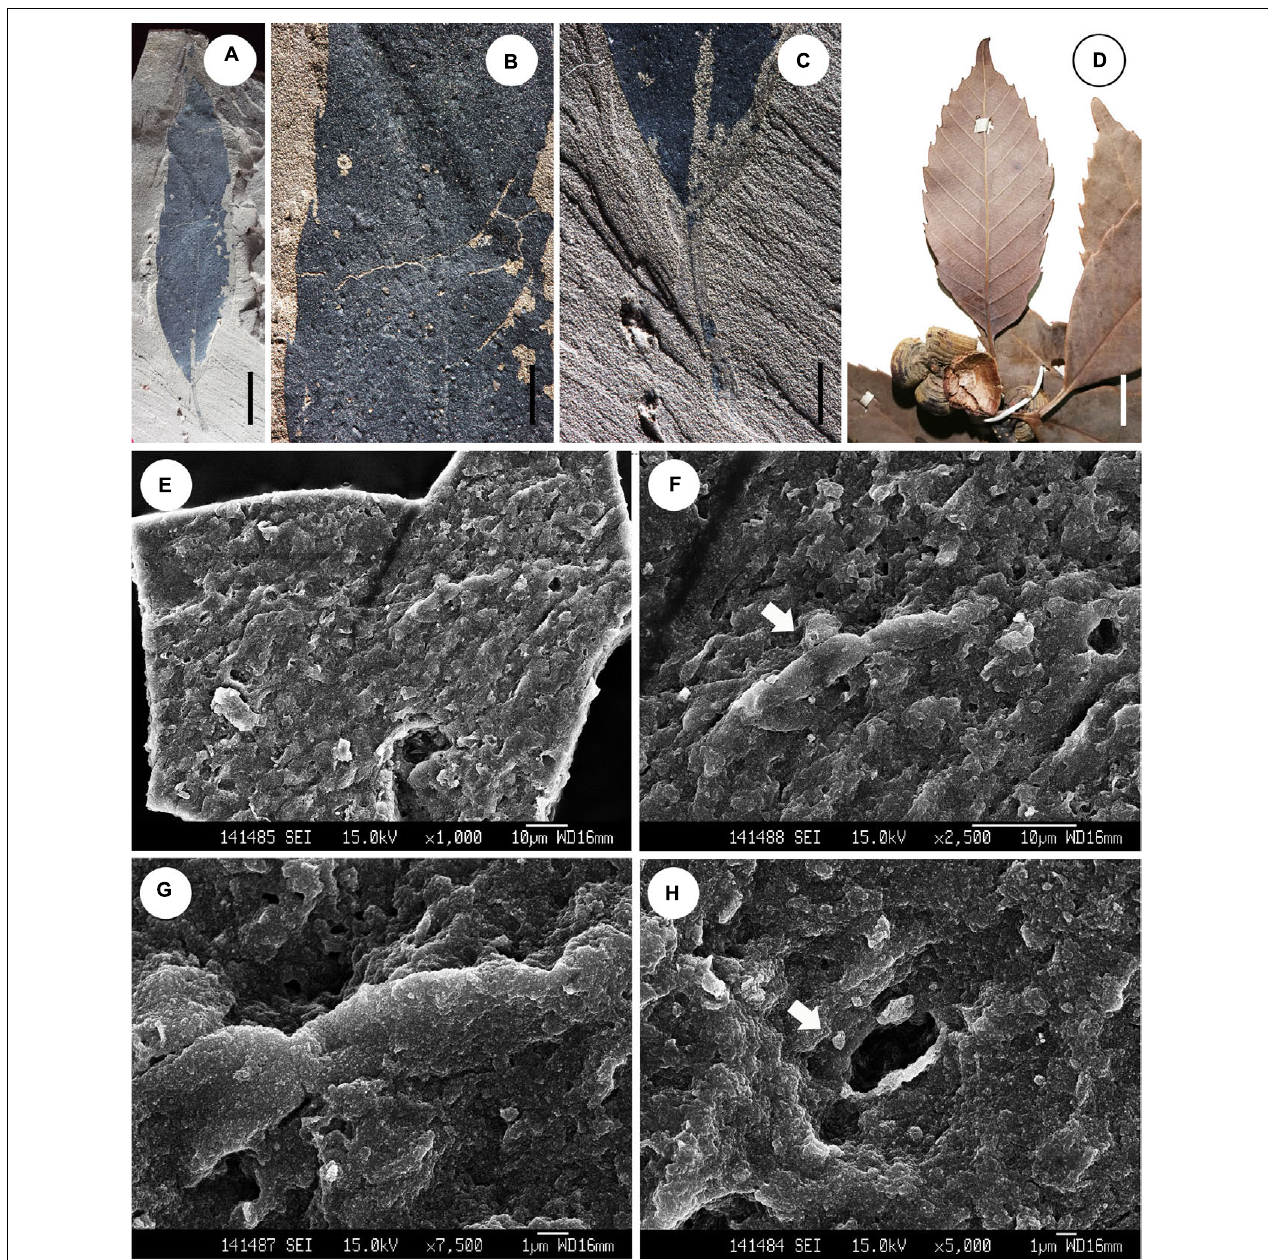
FIGURE 13 | Morphology of Quercus changchangensis sp. nov. (A–C,E–H) and the extant Q. schottkyana Rehd. et Wils. (D) . (A) Holotype. Specimen No. CC-960, showing the lanceolate leaf morphology; (B) enlargement of (A) , showing the teeth; (C) enlargement of (A) , showing the cuneate base and petiole; (D) elliptic leaf of Q. schottkyana, the Herbarium of the Sun Yat-sen University (SYS), No. 17306, collected by J. F. Rock; (E) SEM image showing the rugose outer surface of Q. changchangensis ; (F) enlargement of (E) , white arrow indicates a uniseriate trichome; (G) enlargement of (F) , a cell of the uniseriate trichome; (H) outer face of Q. changchangensis , white arrow indicates the air hole of a stoma. Scale bars: 10 mm (A,D) ; 5 mm (B,C) .